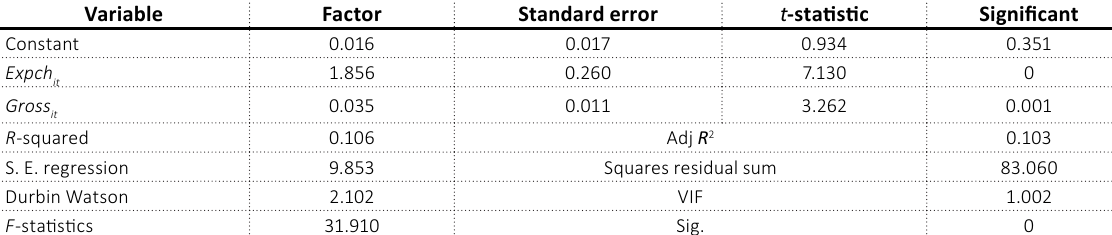
Table 6. Model 2 results